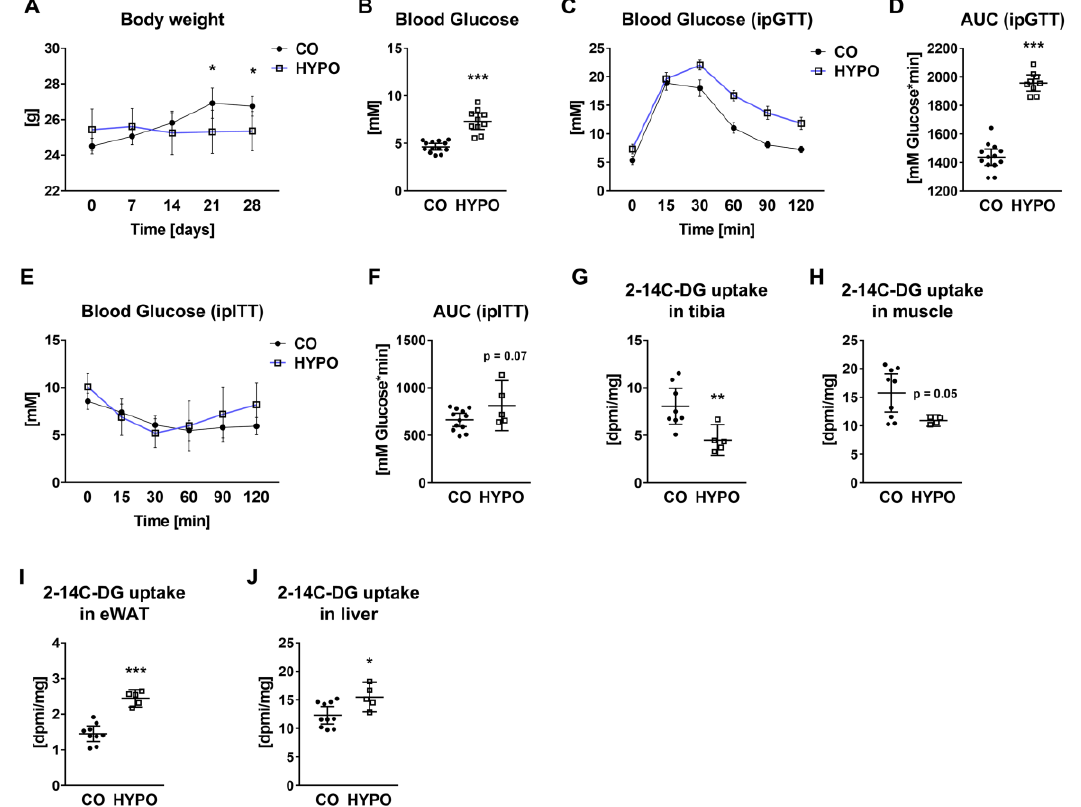
Figure 2. Glucose tolerance, but not insulin sensitivity is impaired in hypothyroid mice. ( A ) Body weights of hypothyroid (HYPO) and control (CO) mice were monitored throughout the 4-week experiment. ( B ) After 16 h of fasting, blood glucose levels were determined from tail vein blood prior to intraperitoneal glucose tolerance test (ipGTT). ( C ) ipGTT started with ip injection of a 20% v/v glucose solution. Blood glucose concentrations were quantified at indicated times up to 2 h. ( D ) The area under the curve (AUC) was calculated to compare glucose tolerance of hypothyroid and control mice. ( E ) Furthermore, intraperitoneal insulin tolerance testing (ipITT) was performed and ( F ) AUC was calculated based on blood glucose levels over time. 2-[14C]-Deoxy-Glucose (2-14C-DG) uptake was tested in ( G ) tibia, ( H ) muscle, ( I ) epididymal WAT (eWAT), and ( J ) liver of hypothyroid vs. control mice. Each dot indicates an individual mouse. The horizontal lines represent the mean ± 95% CI. Body weight curves, fasting blood glucose, and ipGTT: CO: N = 13, HYPO: N = 10; ipITT: CO: N = 12, HYPO: N = 5; 2-14C-DG uptake: CO: N = 10, HYPO: N = 5. Statistical analysis was performed by Student’s t -test: * p < 0.05; ** p < 0.01; *** p < 0.001 vs.